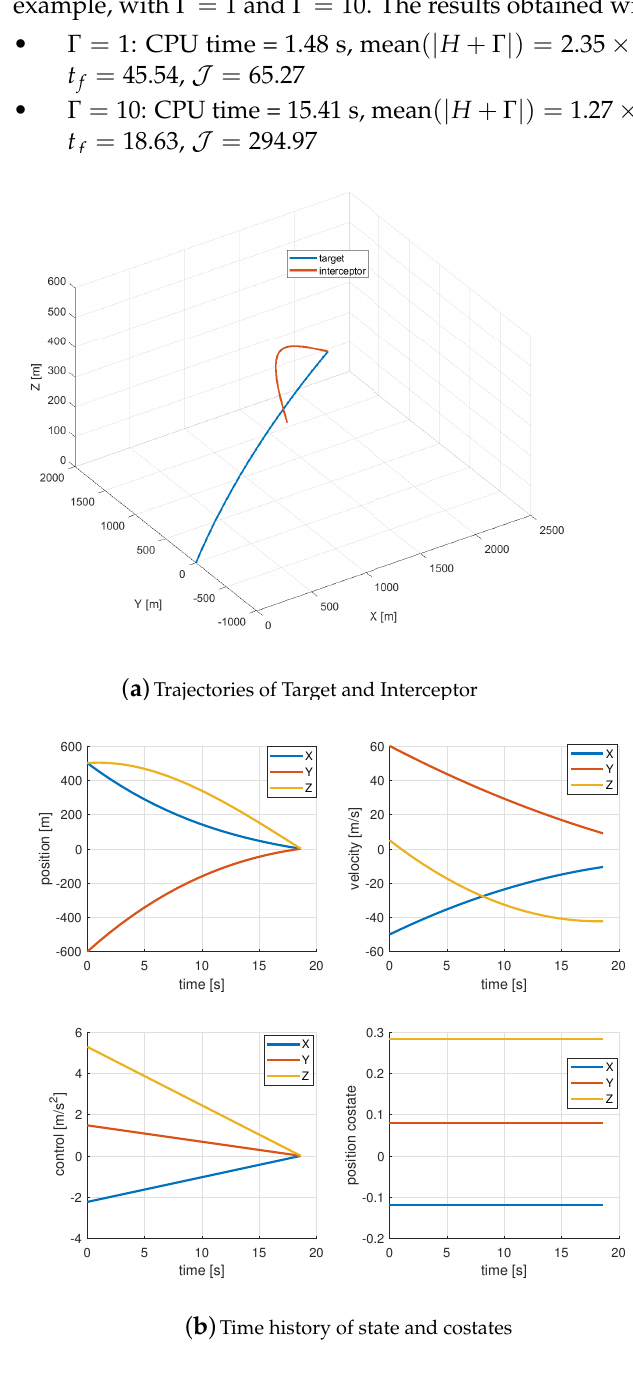
Figure 4. Unconstrained intercept problem with penalty Γ = 10 ( N = 20 and L = 16). Table 2. A summary of the performances of PoNNs in learning the solutions for the minimum time-energy optimal intercept, with N = 20 and L =